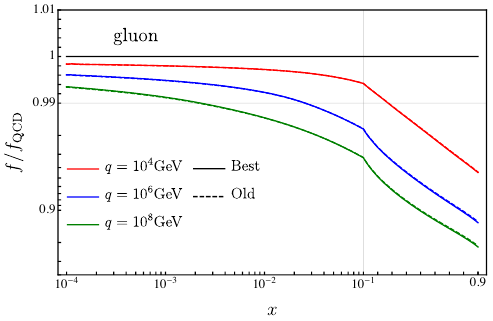
Figure 1 . Gluon PDFs in the full unbroken SM, divided by their values assuming pure QCD evolution only. The thin gray lines show where the scales on the x- and/or y-axes switch between linear and